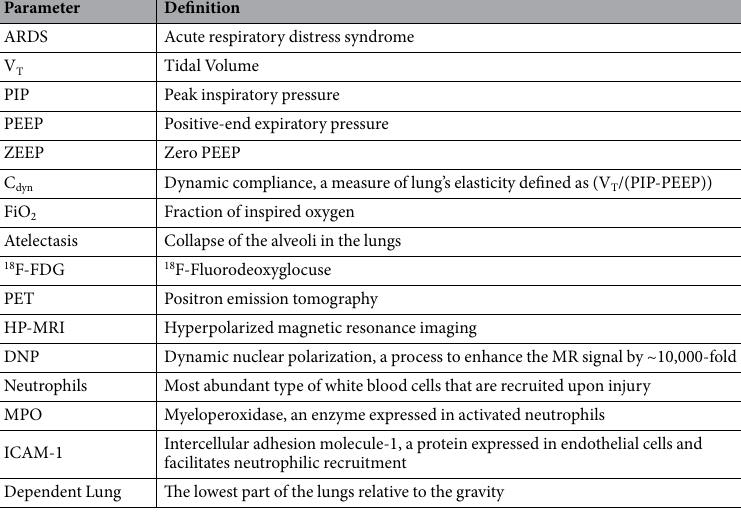
Table 1. List of relevant terms and